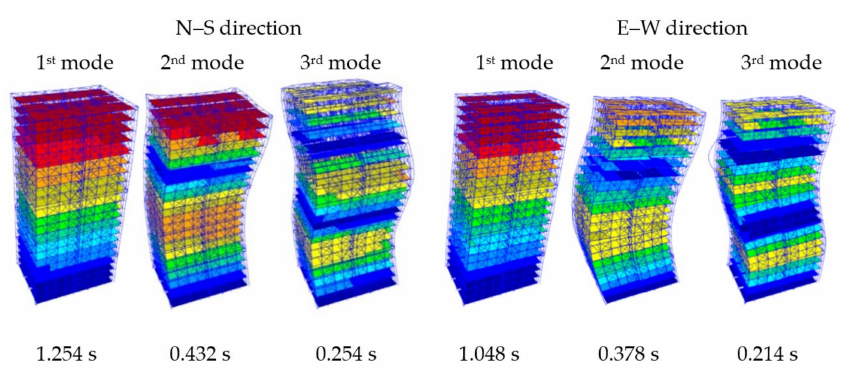
Figure 12. First mode shapes of the glulam concept with the modular substructures connected to the hyperfloors and the columns. Scale ratio of 7. Periods of the modes are under the